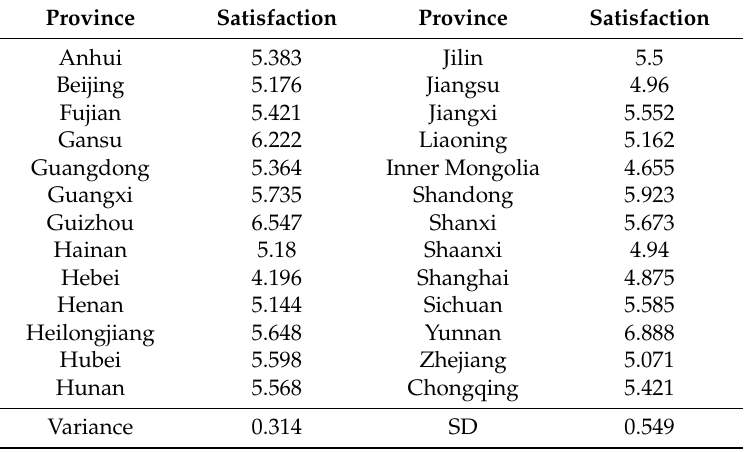
Table 3. Average satisfaction degree in different